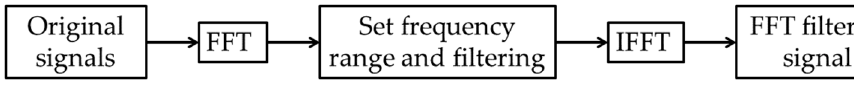
Figure 1. The working FFT flow chart.